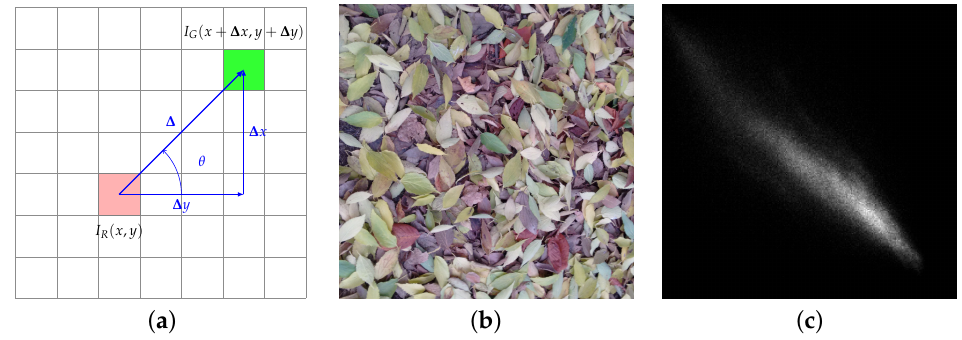
Figure 14. Integrative co-occurrence matrices. From left to right: ( a ) mathematical formulation, ( b ) sample image and ( c ) corresponding inter-class R-G co-occurrence matrix ( δ = 3 √ 2 px, θ = 45 ◦ ). In ( a ) each square of the grid represents one pixel; ( x , y ) indicates the coordinates, and I R ( x , y ) , I G ( x , y ) , respectively, the intensity in the red and green channel. Sample image ( b ) sourced from the T1K+ dataset